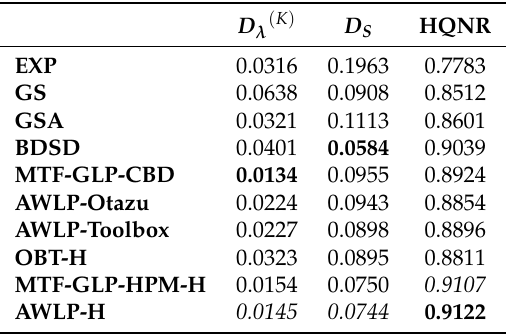
Table 6. Full-scale Khan’s spectral distortion index, QNR spatial distortion index and cumulative score HQNR calculated on the 2048 × 2048 pansharpened WorldView-2 Rio image in Figure 9. Best results in boldface; second best in